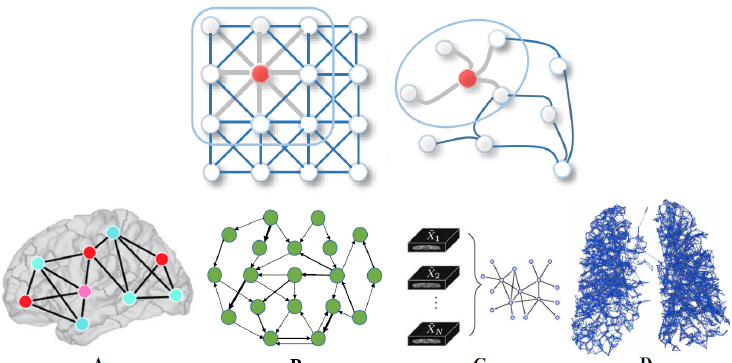
Figure 1. Traditional 2D grid representation and graph-based representation (the neighbours of a node are unordered and variable in size). ( A , B ) Brain graph of f MRI and EEG data for brain responses and emotion analysis, respectively; ( C ) DMRI sampling represented by a graph (DMRI brain reconstruction); ( D ) Graph-like representation for organ segmentation (CT -pulmonary airway). Image adapted from